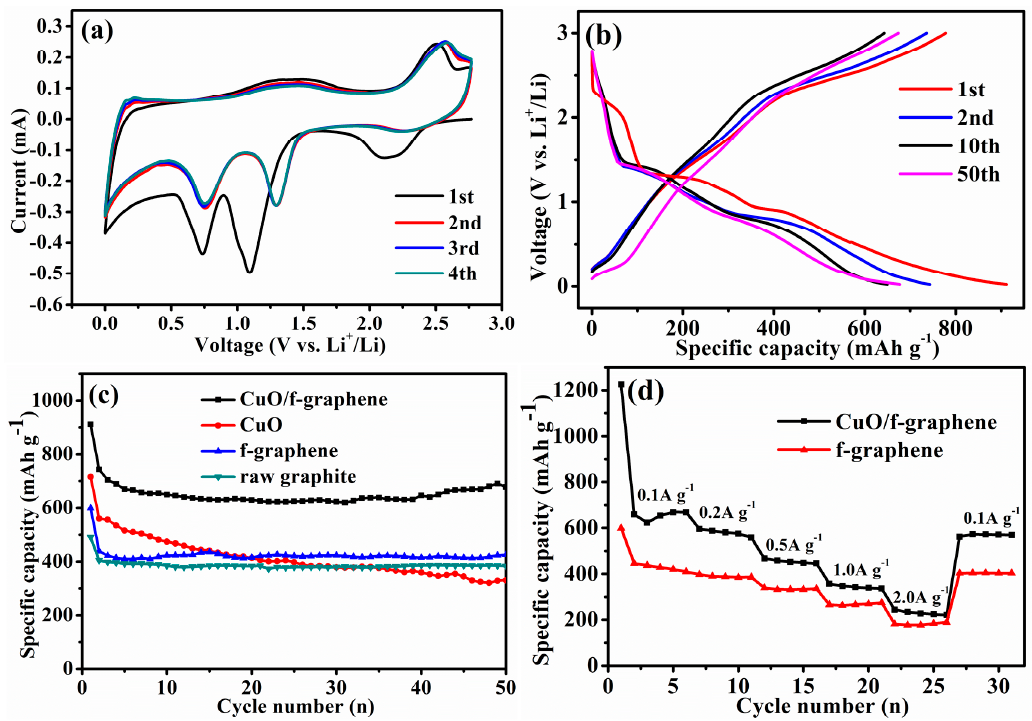
Figure 4. ( a ) The first four CV curves of the CuO/f-graphene composite at a scan rate of 0.1 mV·s − 1 in the potential range of 0–3.0 V (Li + /Li); ( b ) the first, second, tenth, and fiftieth galvanostatic charge/discharge curves of the CuO/f-graphene composite at a current density 100 mA·g − 1 ; ( c ) cycling performance of raw graphite, pure CuO, the f-graphene and the CuO/f-graphene composite at a current density of 100 mA·g − 1 ; and ( d ) the rate performance of the f-graphene and the CuO/f-graphene composite at various current densities ranging from 0.1 to 2.0 A·g − 1 .